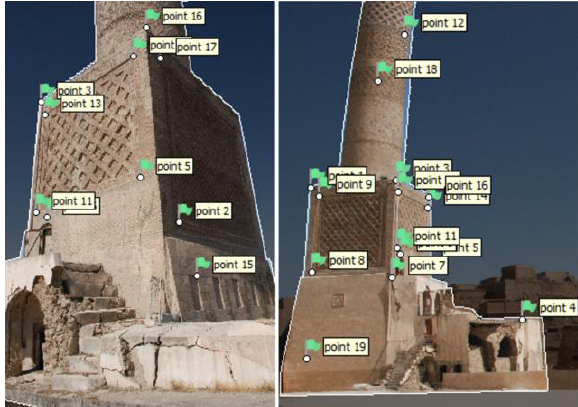
Figure 4. The guided approach in Agisoft